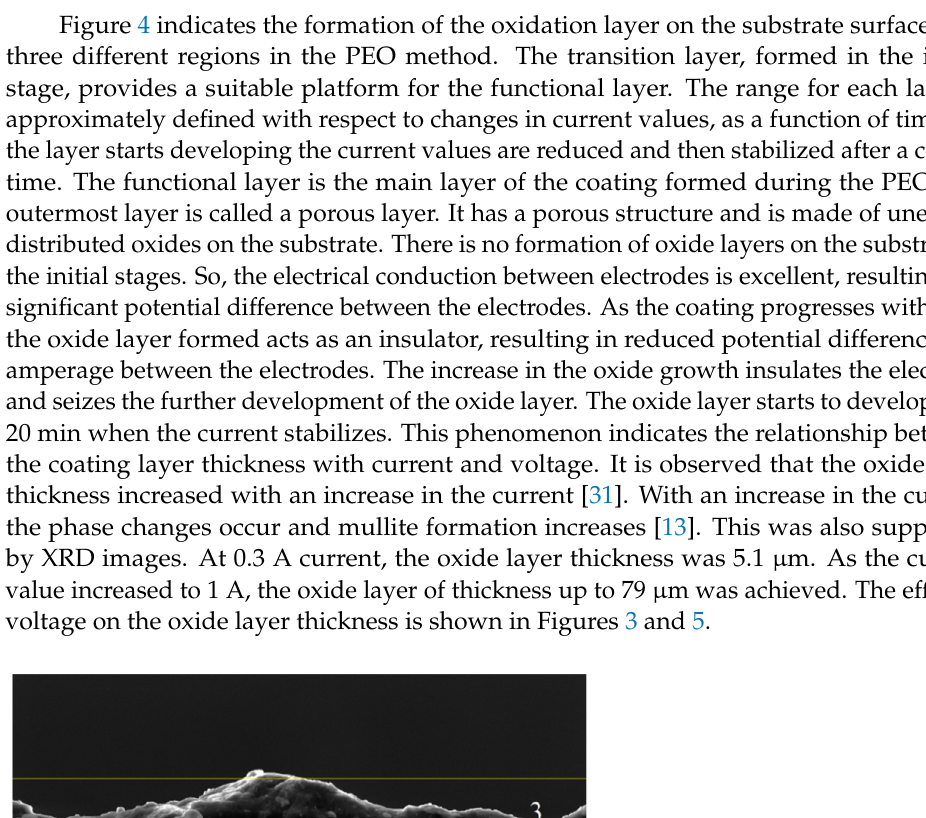
Figure 3. Current-time responses of samples processed at different electrode distances of 10, 30, 35, 40 mm.